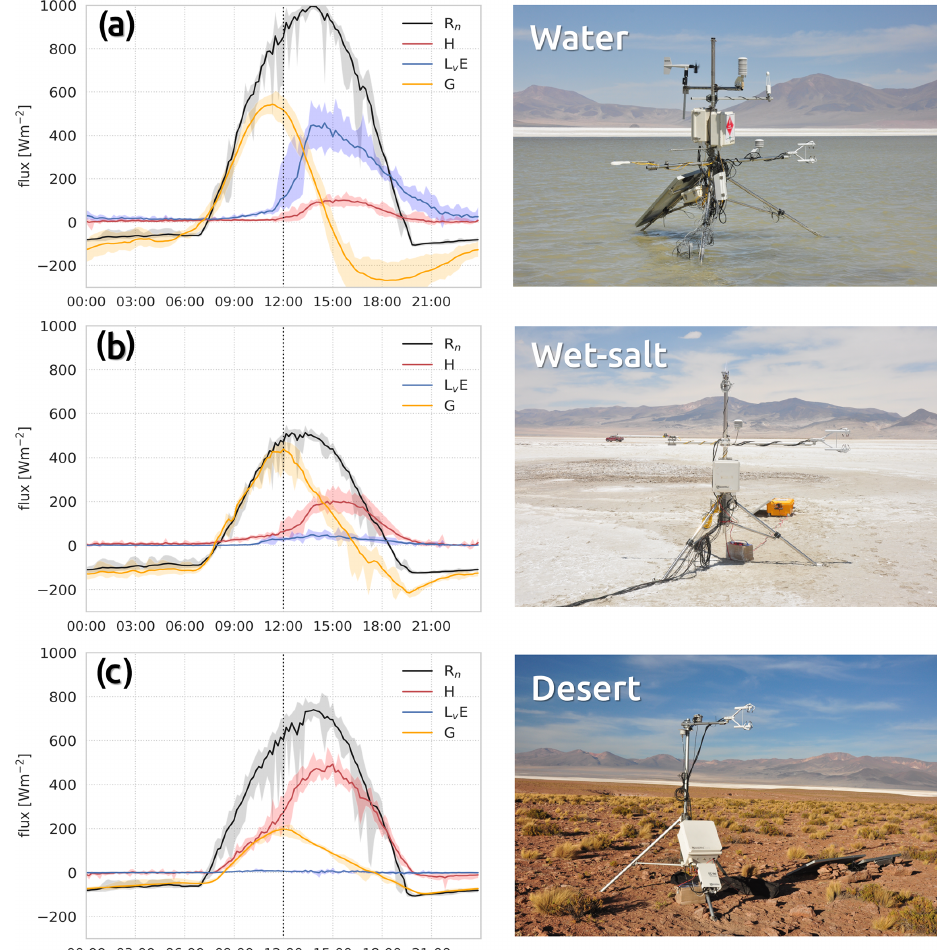
Figure 3. Diurnal cycle of the surface energy balance (SEB) observed during the E-DATA field experiment. Mean separated components are shown in colour lines and maxima and minima by shadings. Panels (a) – (c) show the SEB over the water, wet-salt and desert surfaces, respectively. Vertical dotted lines indicate the time of regime change. A photograph of each SEB station installed is shown at the right side of each